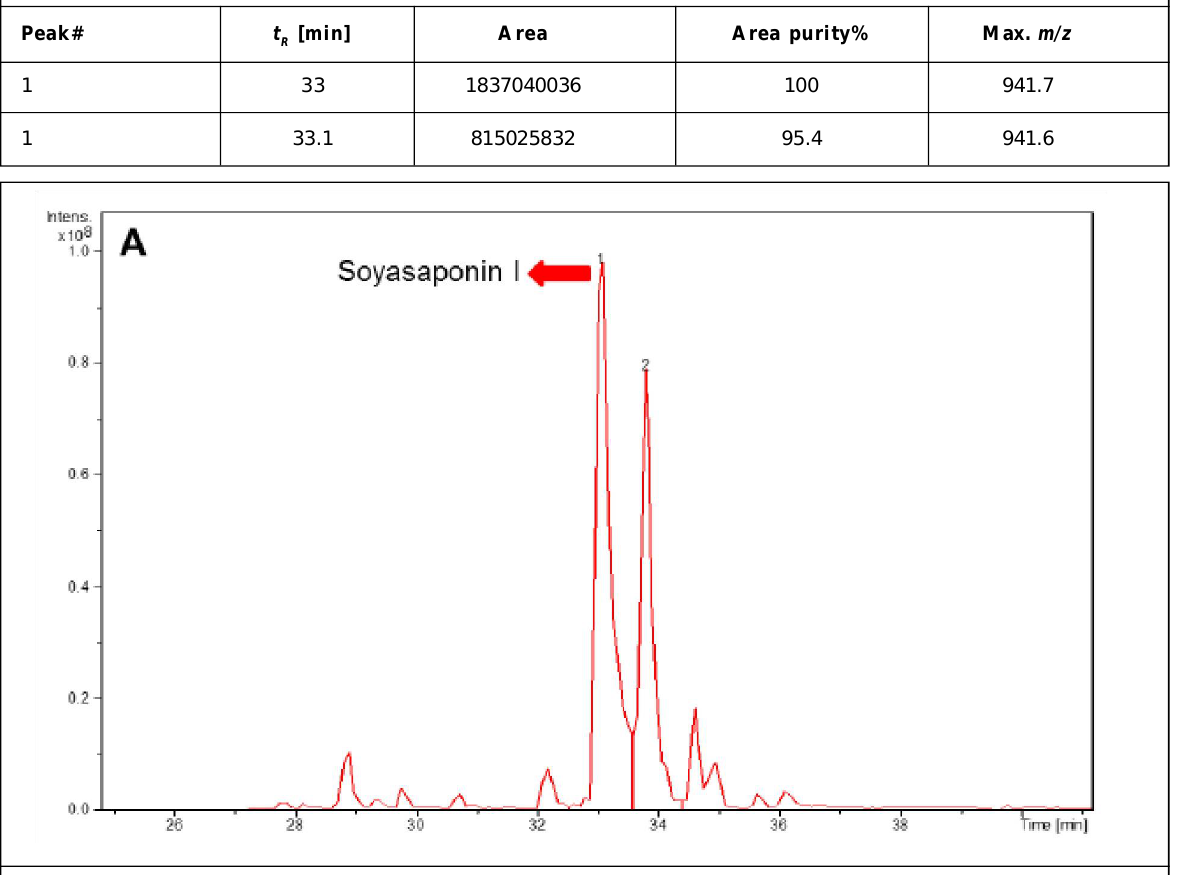
Table 1: Retention time, area purity % and m/z values of the n -butnolic fractions major peaks of both T. speciosa cultured cells (calli) and the dried leaves extract